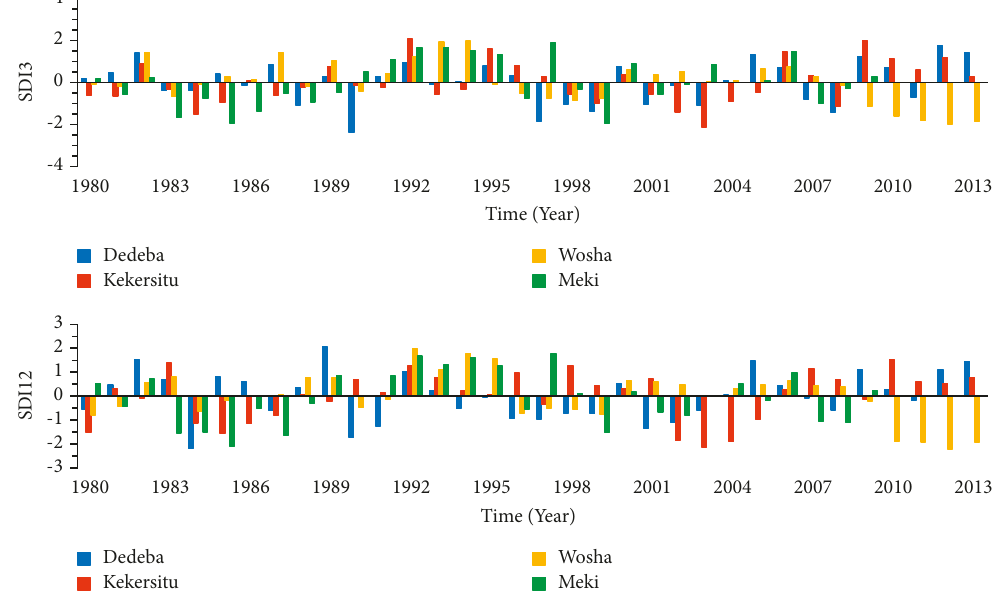
Figure 9: Temporal variation in seasonal (SDI3) and annual (SDI12) for Rift Valley River